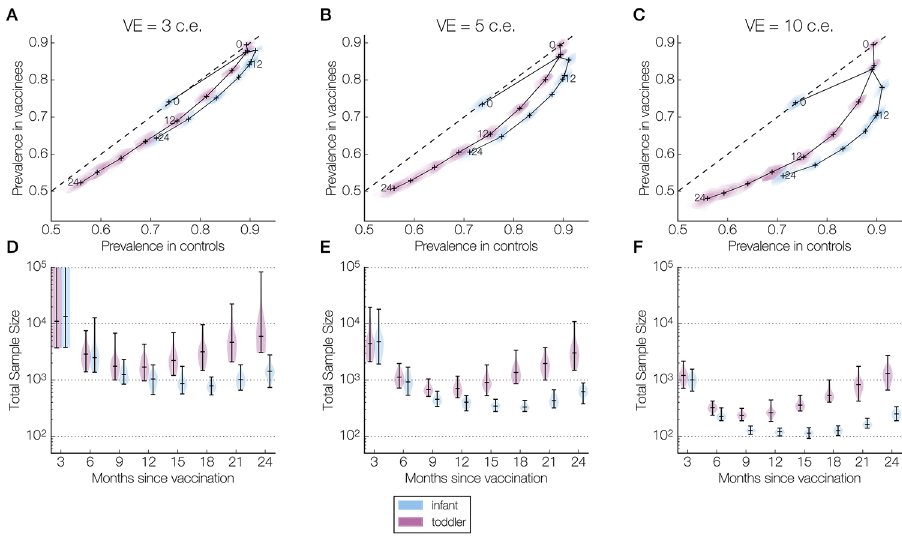
Fig 2. Prevalence and sample size over the follow-up period in the higher transmission setting. Panels are organized column-wise by vaccine efficacy: 3 colonization equivalents (c.e.), or 26% reduction in carriage duration (A, D); 5 c.e., or 39% (B, E); and 10 c.e., or 63% (C, F). Within each panel, results are presented separately for infants (blue) and toddlers (purple). (A-C) The joint kernel density estimate (see Methods) of the control and vaccine arm prevalences at each sampling time (every 3 months until 24 months post-vaccination) is shown as a contour map truncated by the convex hull of the simulated points, with the median values marked by a cross. These crosses are connected chronologically, and those corresponding to 0, 12, and 24 months post-vaccination are labeled. The dashed line indicates equal prevalences in the two arms. (D-F) The kernel density estimate of the total sample size (combined size of both samples) needed to detect a difference between control and vaccine arm prevalences at each sampling time (assuming 80% power, 5% type I error rate, balanced arms). The horizontal bars in each violin plot indicate the minimum, median, and maximum values across all simulations. In (D), the maximum sample sizes for infants and for toddlers at 3 months post-vaccination are greater than one million (236 million and 4 million, respectively) and outside the limits of the